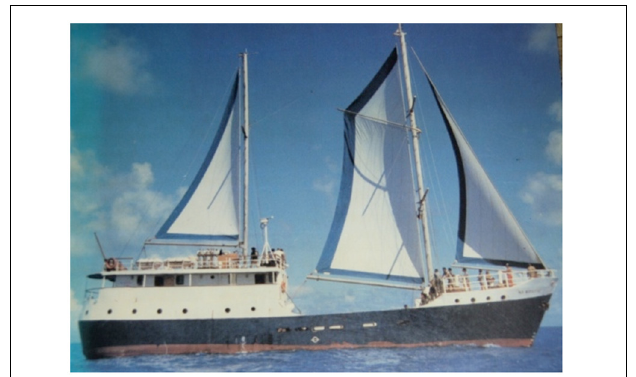
FIGURE 2 | Na Mataisau , Fiji, 1984 (source: ADB, 1985).